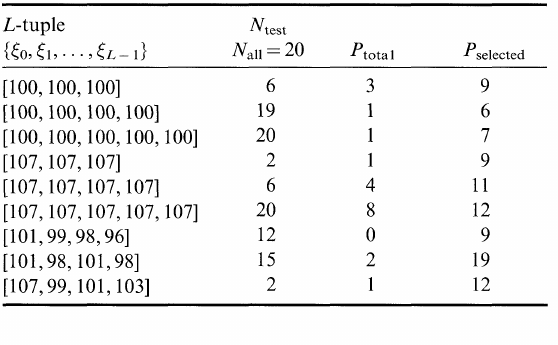
TABLE IV Results of runs tests for the reordered time series of Table III. Ptotal (Pselected) is the number of total (selected) reordered time series for which the independence hypothesis (no temporal order) is rejected (e